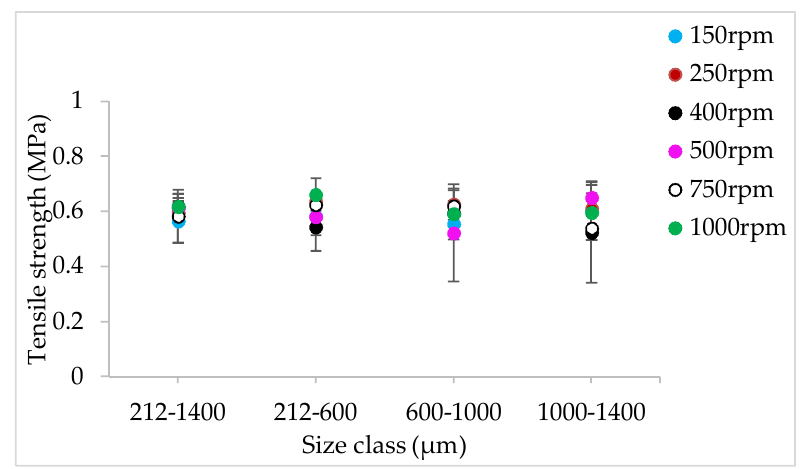
Figure 13. Tensile strength of tablets of lactose granules produced at varying screw speed at SFL—0.166 and PFN—6.85612 × 10 −5 (L/S 0.048).